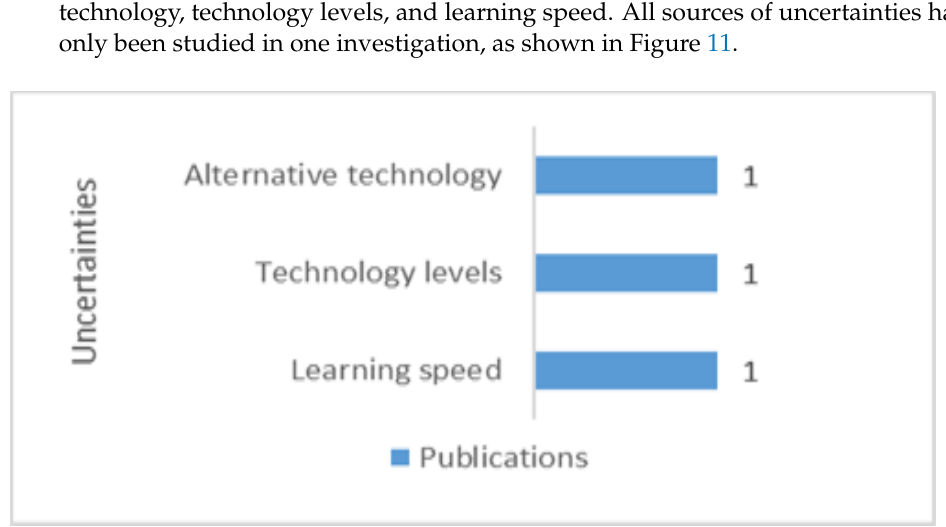
Table 5. Type of uncertainties explored in research with a real options approach.